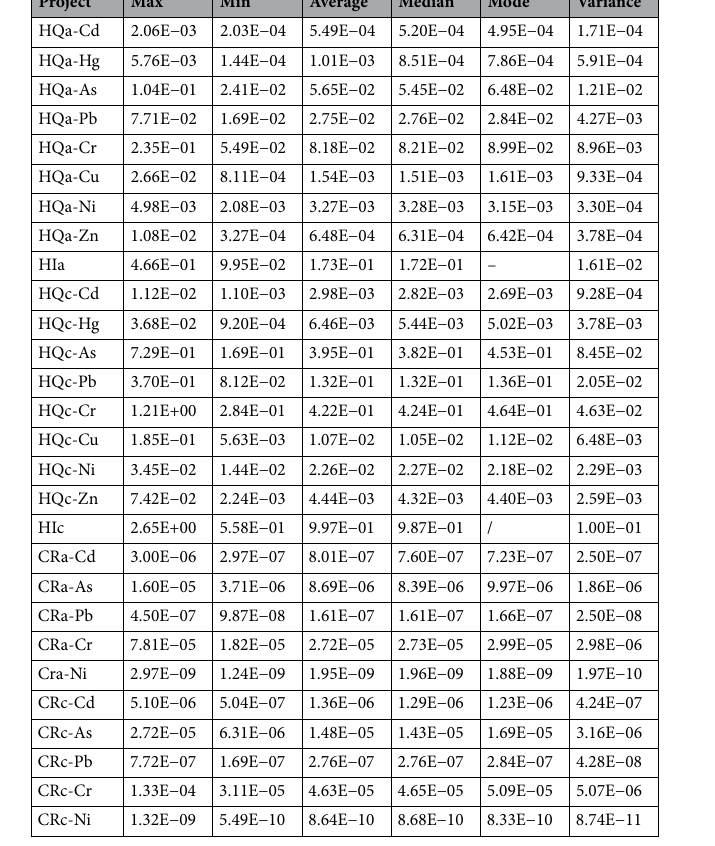
Table 3. Statistics analysis for overall health risk of HMs of study